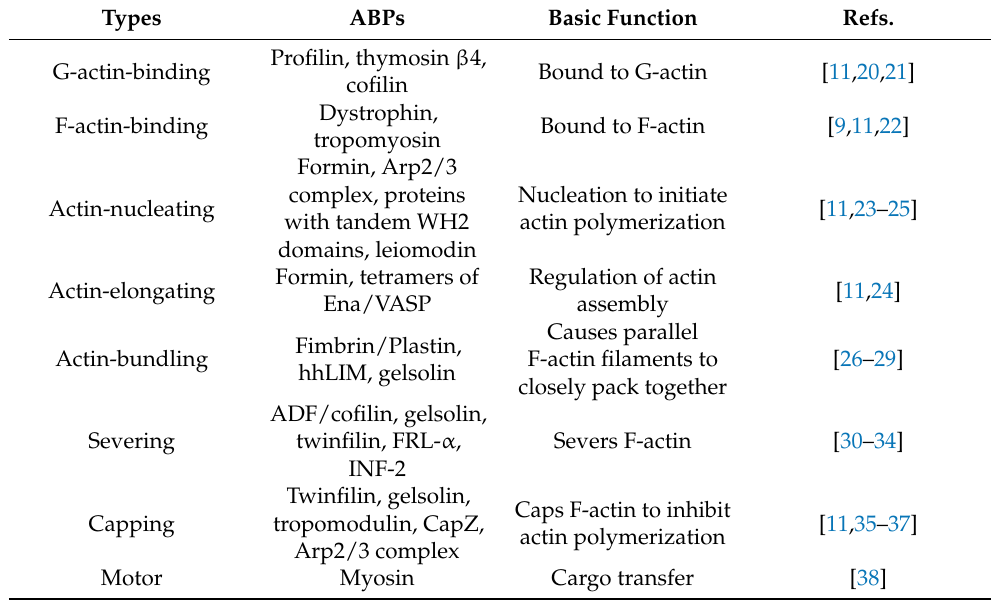
Table 1. Actin-binding